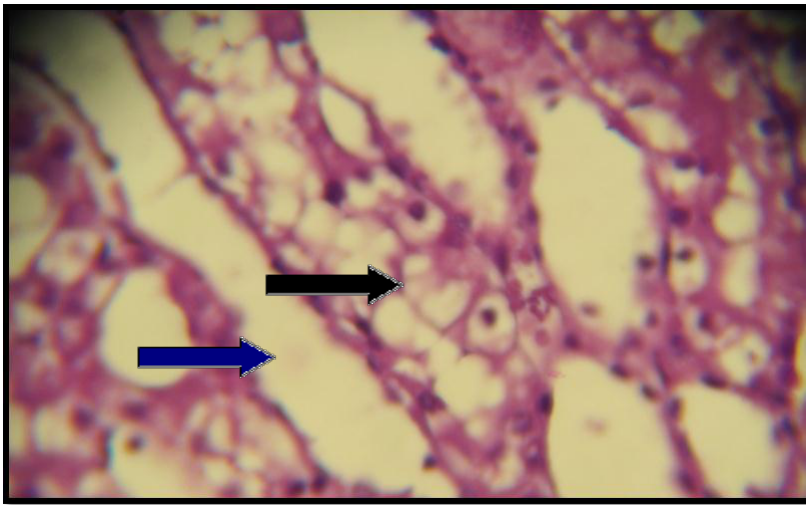
Figure (3): Histological